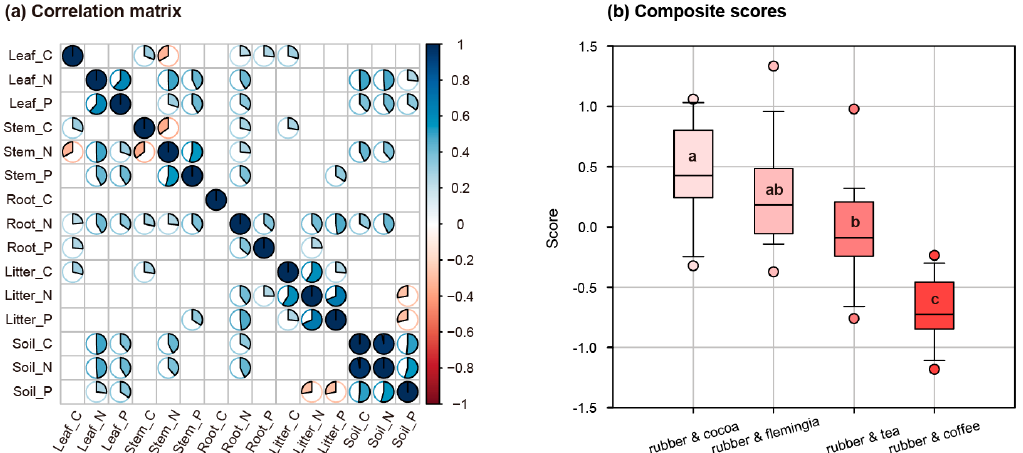
Figure 3. The results of factor analysis including ( a ) the correlations among all NRCI indexes, which were calculated through the C, N, and P concentrations of the rubber leaves (Leaf_C, Leaf_N, Leaf_P), rubber stems (Stem_C, Stem_N, Stem_P), rubber roots (Root_C, Root_N, Root_P), litter (Litter_C, Litter_N, Litter_P), and soil (Soil_C, Soil_N, Soil_P), respectively; ( b ) the composite scores of each site. “FA” is short for “factor analysis”. Di ff erent lowercase letters indicate significant di ff erences among the AFSs ( p <